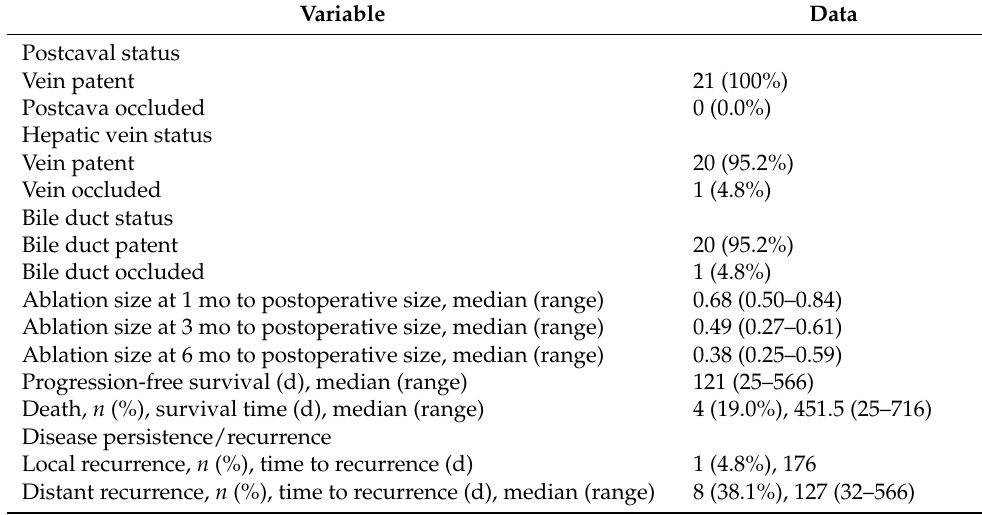
Table 6. Postoperative